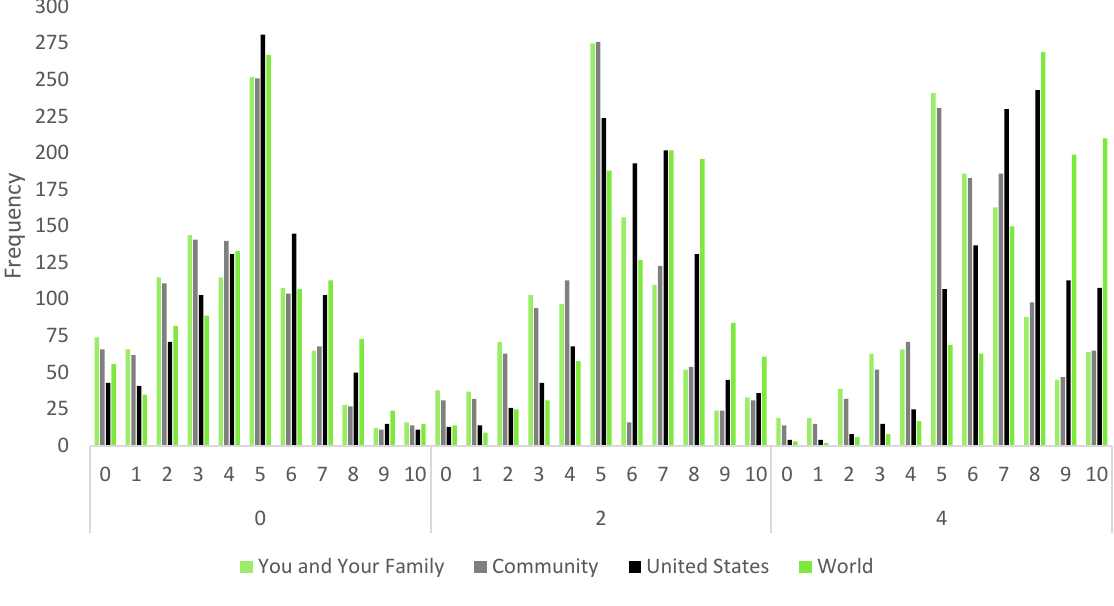
Figure 4. Simulated influence of ecological values on health risk perceptions in all four groups.